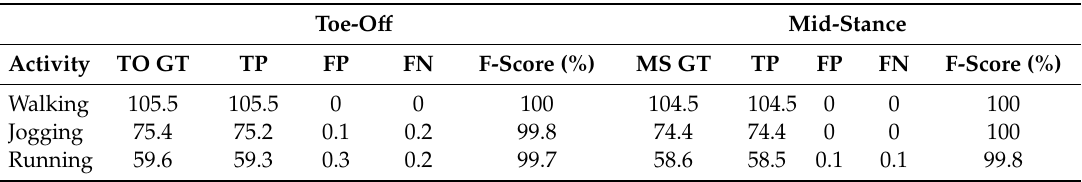
Table 3. Averaged results of TO and MS detection for the 10 participants in the Unicauca dataset using the proposed TO and MS detection algorithms. Toe-O ff